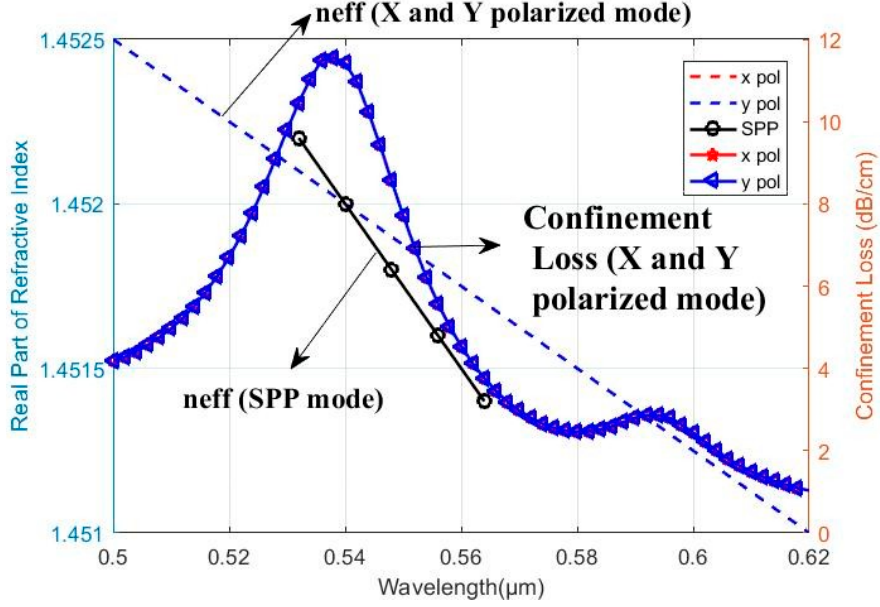
Figure 4. The resonance behavior of proposed PCF-SPR biosensor for Jurkat (cancerous) cell. Table 2. Proposed PCF-SPR biosensor’s sensitivity analysis.